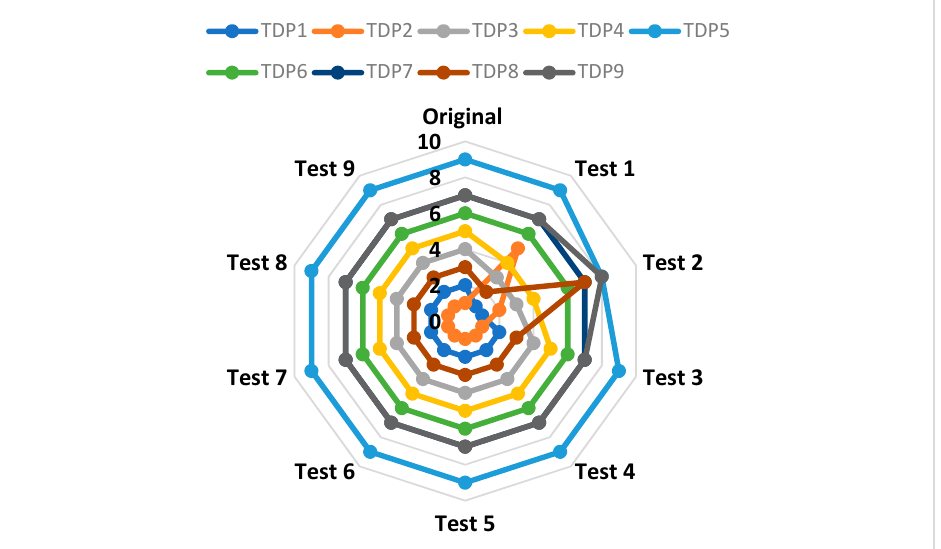
Figure 2. The illustrative ranking of Technology 4.0 driven practices in nine tests.